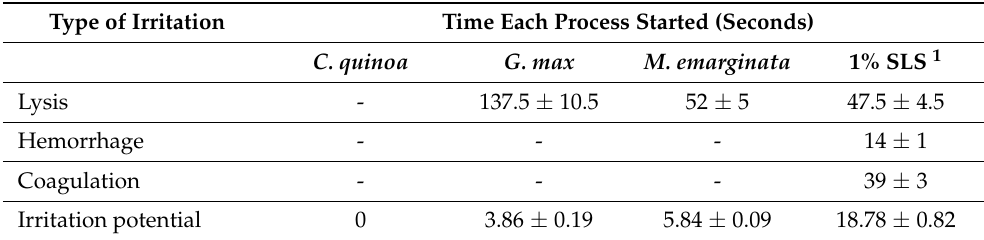
Table 5. Results of hen’s egg chorioallantoic membrane test applied to the extracts of Chenopodium quinoa , Glycine max , and Malpighia emarginata